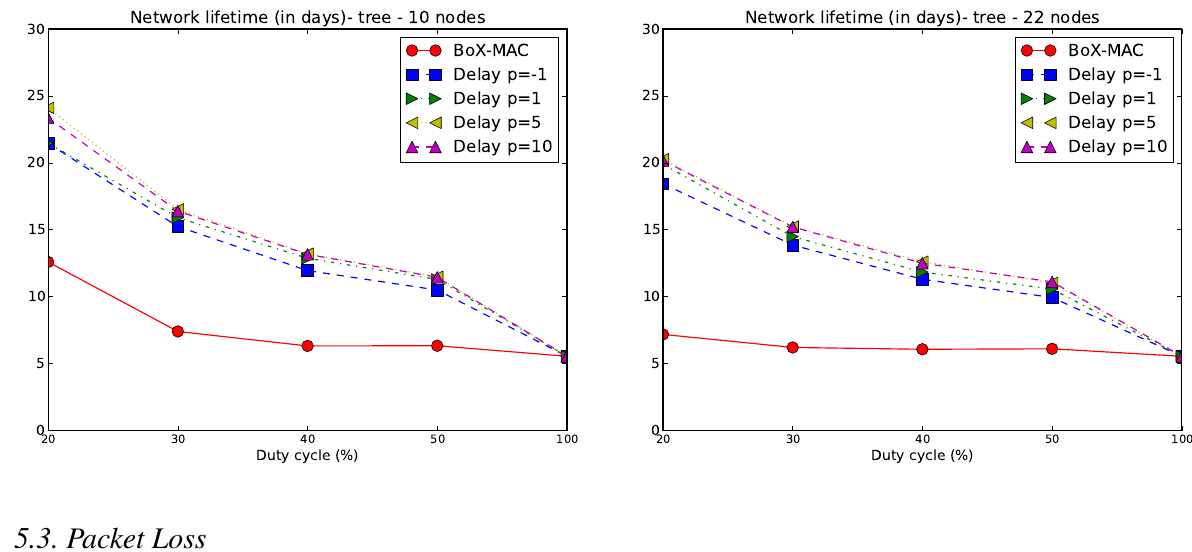
Figure 10. Network lifetime (in days) for 10-node (left) and 22-node (right) tree topologies.